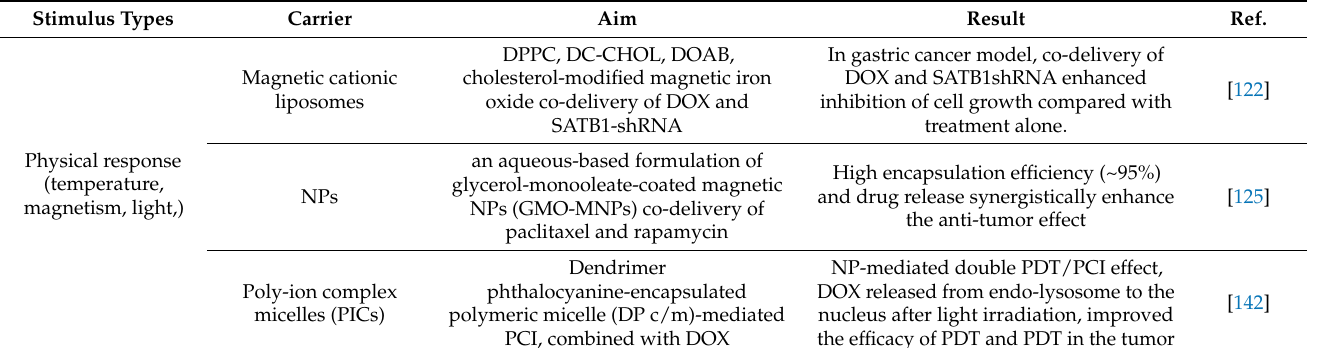
Table 2. List of some of the sensitive systems based on internal and external stimuli used for co- delivery of drugs in cancer